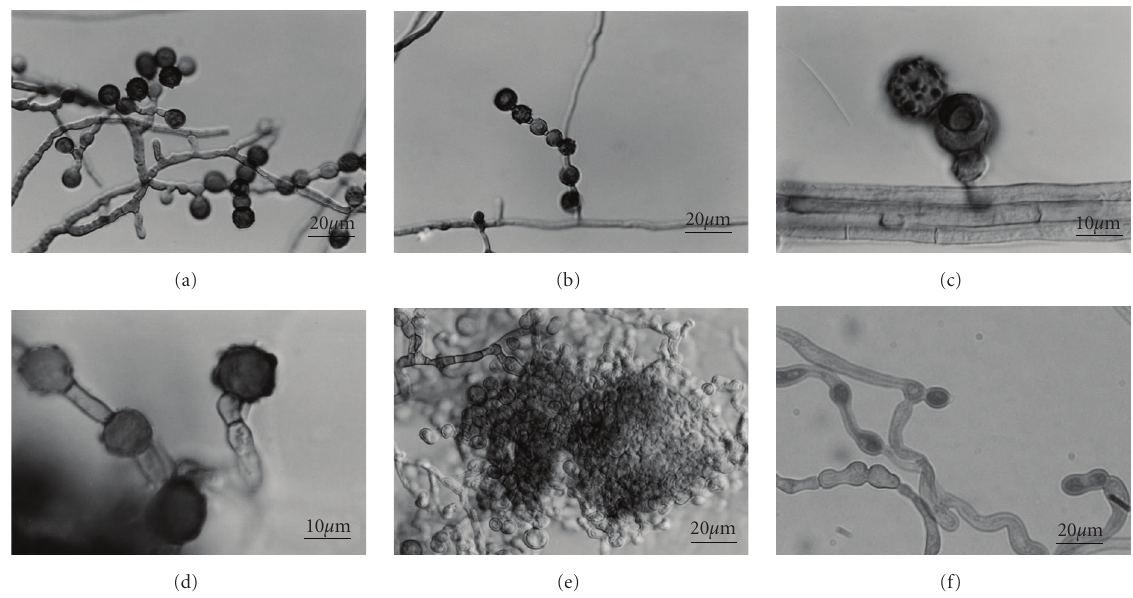
Figure 1: Morphology of RB-1 grown on PDA under aerobic conditions: (a)–(e) as viewed by di ff erential interference contrast microscopy, and under anaerobic conditions (f) as viewed by phase contrast microscopy. (a) Alleurio conidia and conidiogenous cells; (b) formation of chained conidia; (c) a verrucose surface structure of the conidium; (d) conidia and chlamydospores; (e) a structure indicative of some primordia; and (f) conidia- and chlamydospore-like structures of an anaerobically grown